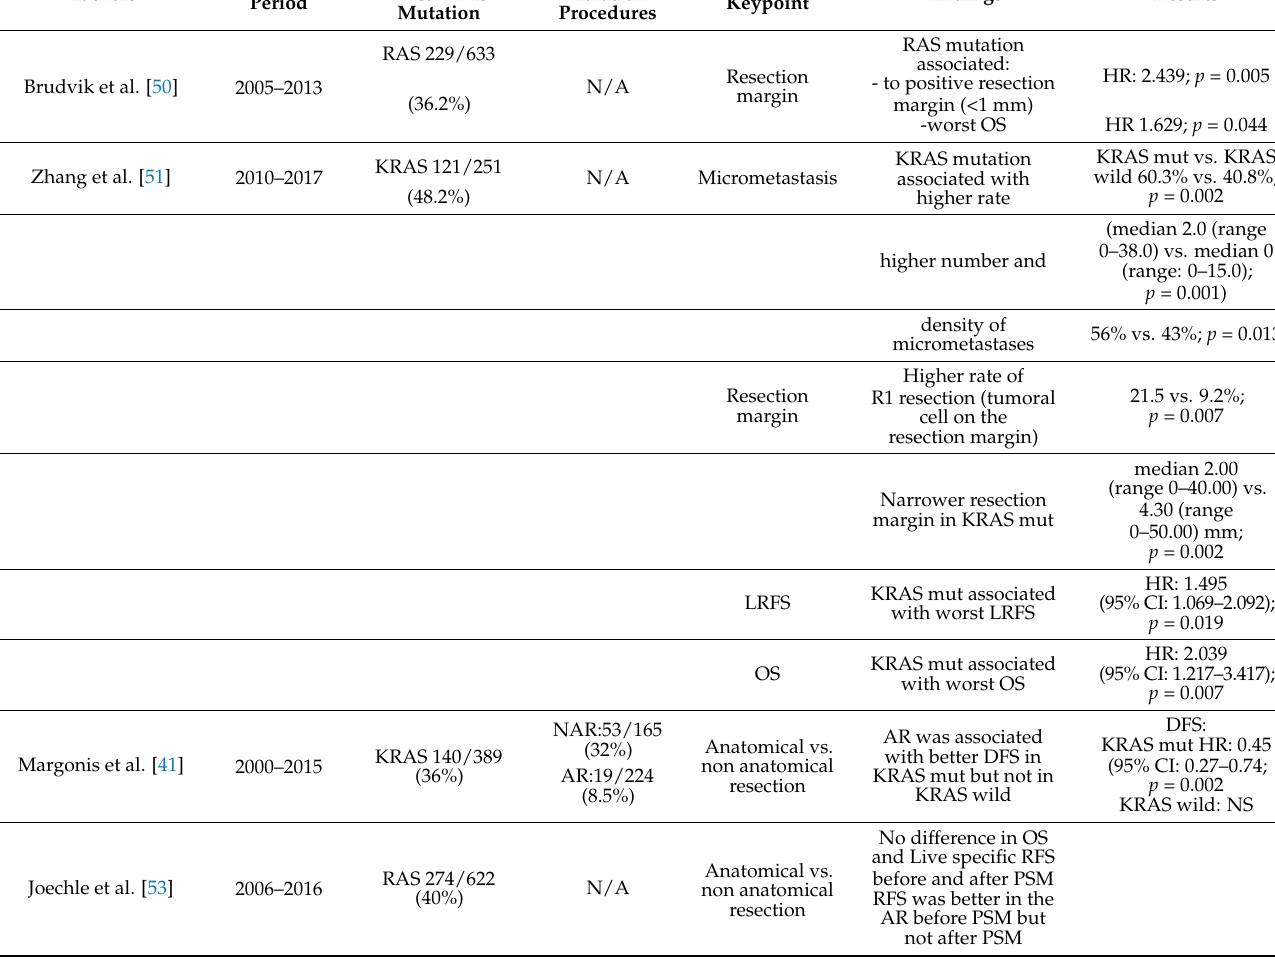
Anatomical vs. non anatomical